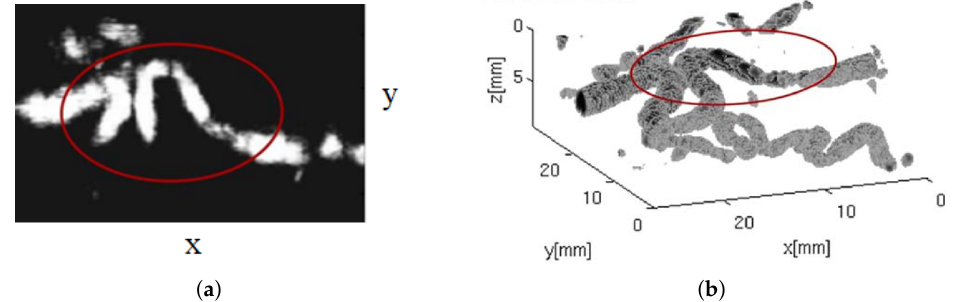
Figure 5. Example of a palm vein pattern collected through power Doppler analysis: ( a ) 2D pattern and ( b ) 3D pattern, which provides improved distinctiveness. Reprinted with permission from [88].